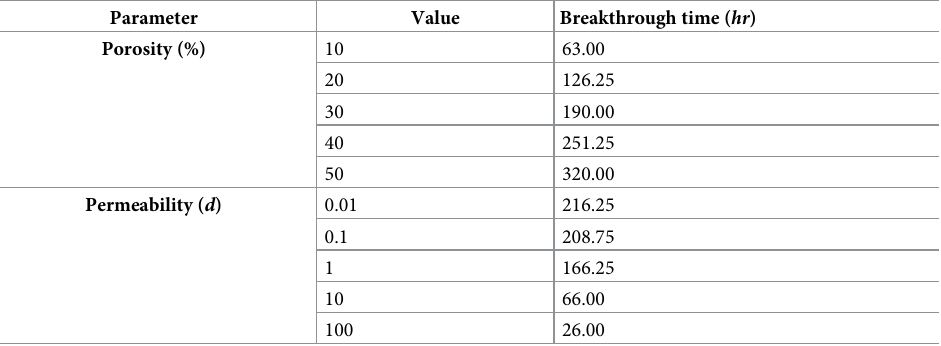
Table 6. Calculated breakthrough times for the porosity and permeability sensitivity